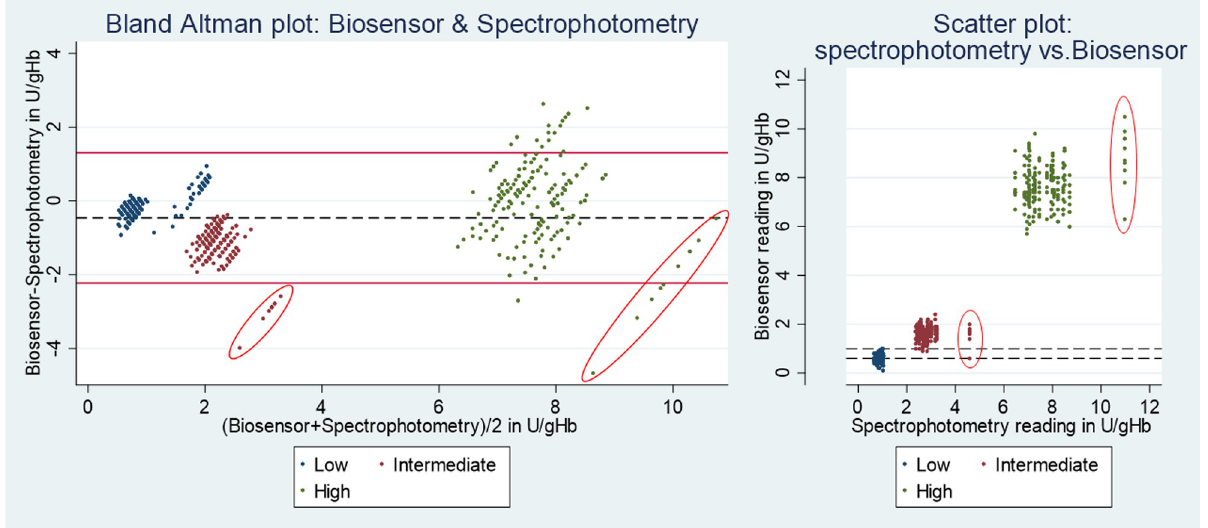
Fig 4. Phase A: G6PD activity measured by Biosensor and spectrophotometry. Red circled results are influential points generated by spectrophotometry; Left: Red horizontal lines indicate upper and lower end of 95% limit of agreement, black dotted line indicates mean difference. Right: horizontal dotted lines indicate the overlap between Low and Intermediate readings by Biosensor.